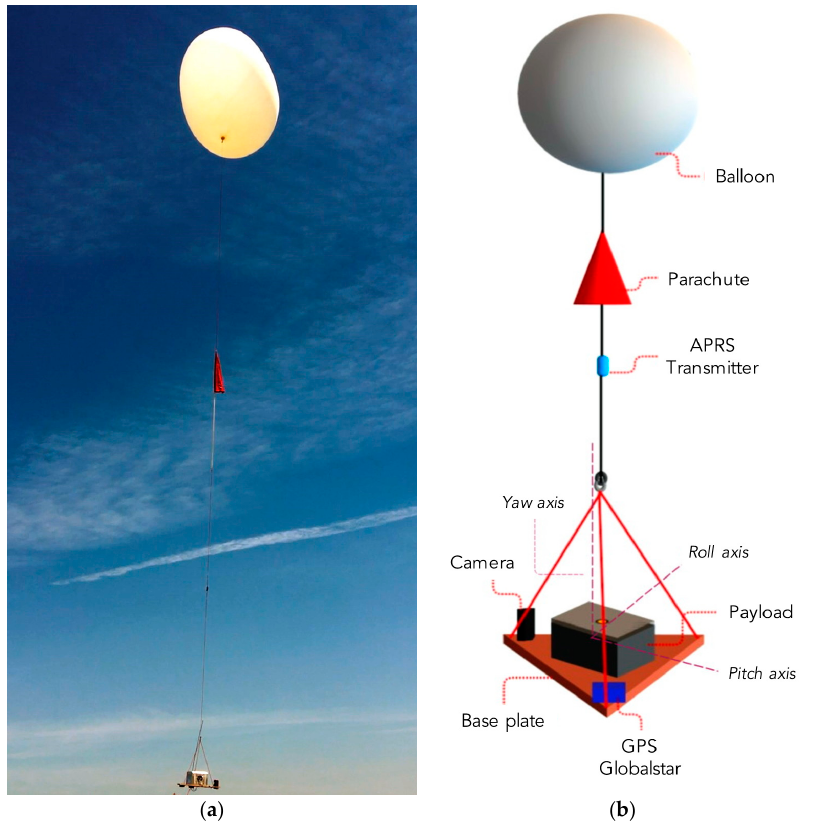
Figure 1. The Industrial-Scientific-Medical High Altitude Balloon (ISM-HAB) sounding balloon flight train. ( a ) Immediately after release at launch. ( b )